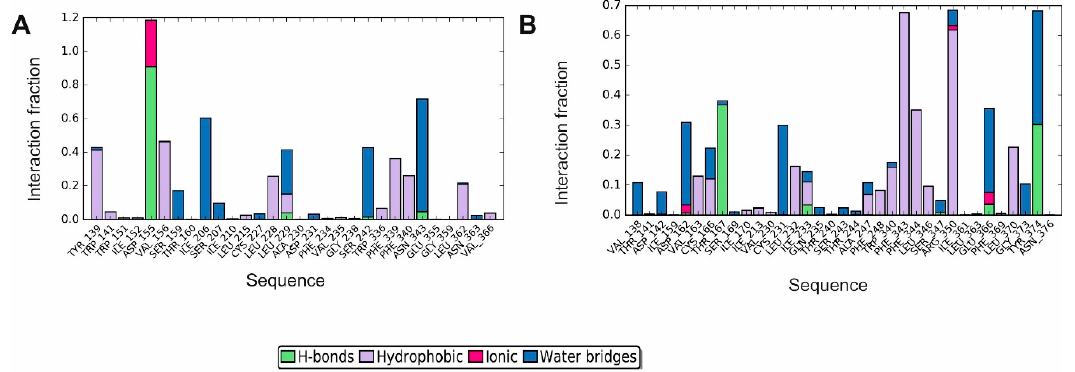
Figure 7. Molecular interactions of D2AAK4 with human serotonin 5-HT 2A ( A ) and 5-HT 7 ( B ) receptor during 200 ns molecular dynamics simulations: histogram of interactions. The stacked bar charts are normalized over the course of the trajectory: for example, a value of 0.7 suggests that for 70% of the simulation time the specific interaction is maintained. Values over 1.0 are possible as some protein residue may make multiple contacts of the same subtype with the ligand.